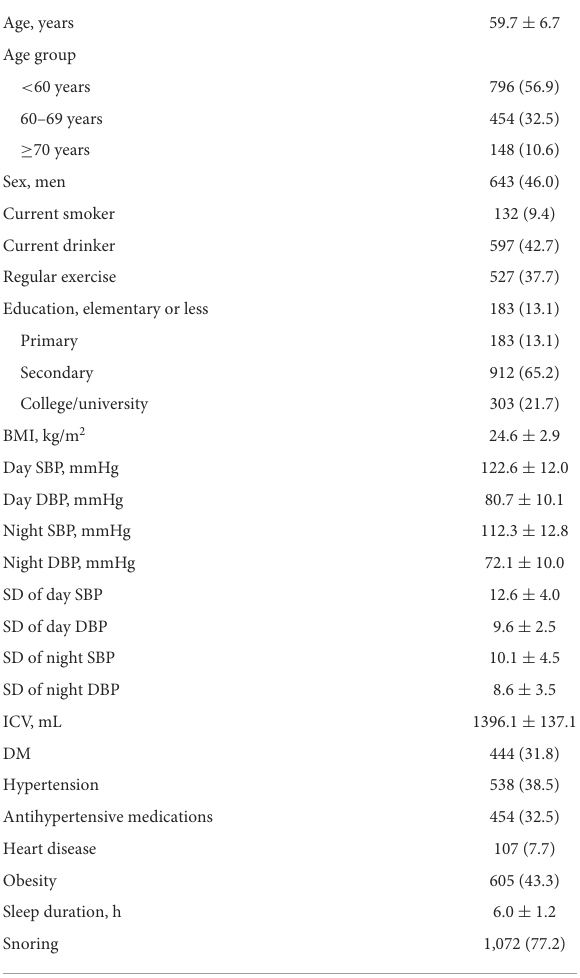
TABLE 1 Baseline characteristics of the study